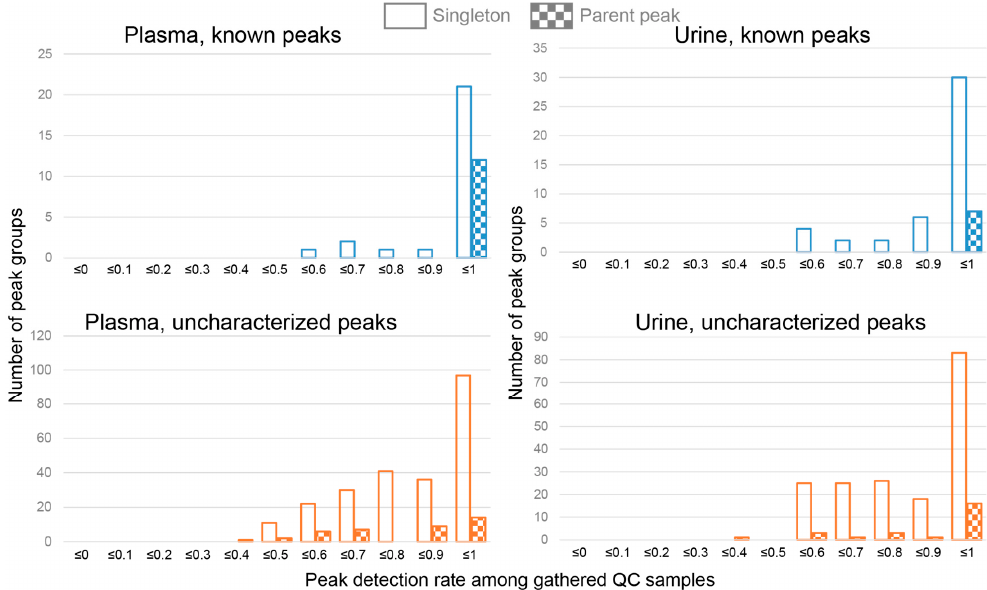
Figure 2. Distribution of peak detection rates among the 30 gathered quality control (QC) samples. Parent peak, a peak that was associated with a potential isotope ion or an adduct ion; singleton, a peak that was not a parent peak.